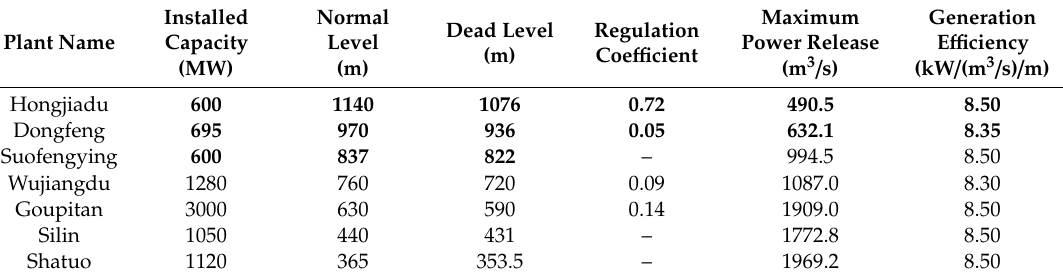
Figure 2. The distribution chart of the Wu River cascade. Table 2. Characteristics of the studied hydropower plants on the Wu River.